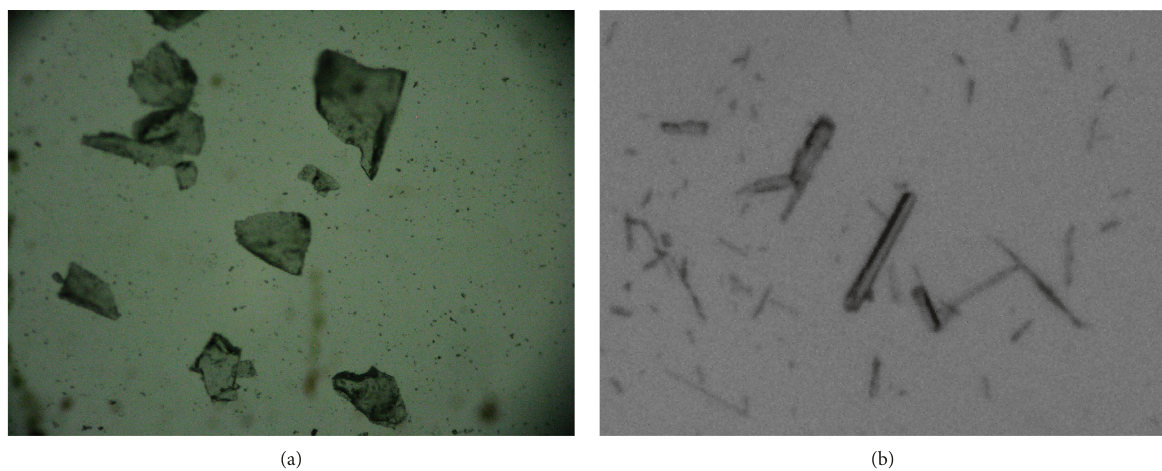
Figure 2: Pictures taken at the polarized light microscope of (a) LISZn1 and (b) LISZn2 showing their distinct solid habits.